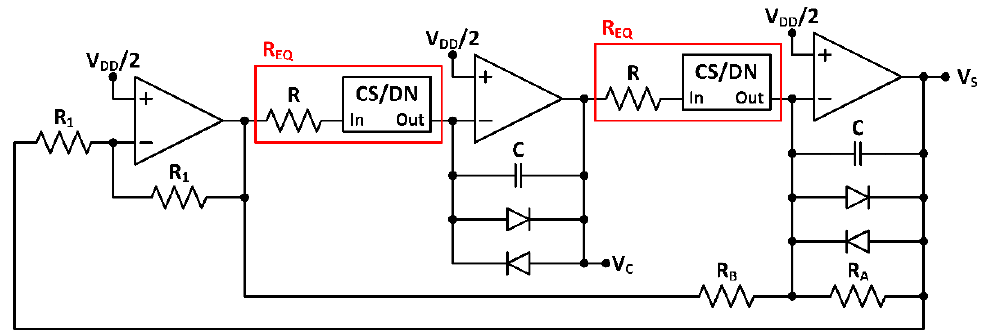
Figure 2. Proposed programmable quadrature oscillator topology.